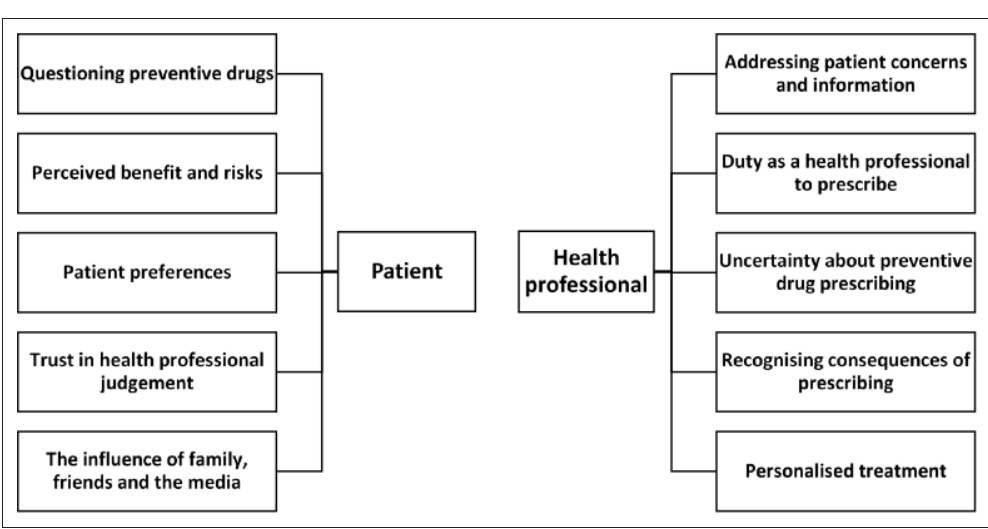
Figure 2 Diagram of patient and health professional related